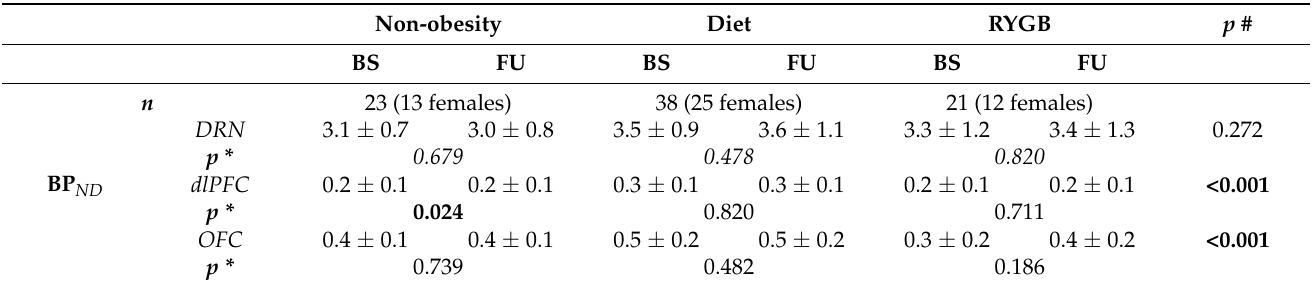
Table 2. 5-HTT BP ND values of study participants at baseline (BS) and follow-up (FU) allocated to the type of intervention.